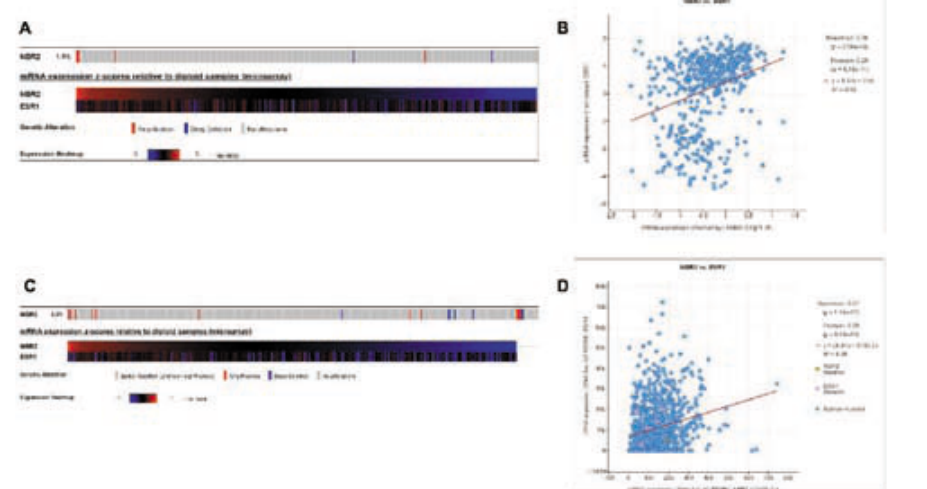
Figure. 1 . a & c represent heatmaps of NBR2 and ESR1 from two human breast cancer patient datasets TCGA Nature 2012 (825 samples) and TCGA Firehouse Legacy (1108 samples) respectively. B & D depict co-expression analysis of NBR2 and ESR1 mRNA levels from the same